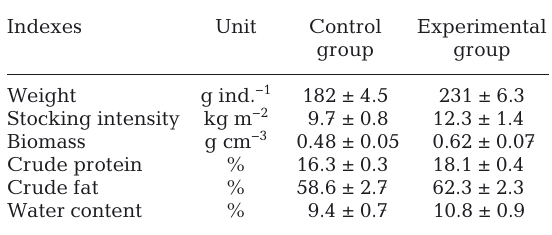
5. Mean (±SD) yield and quality of Eriocheir sinensis crabs with practical application of biochar-immobilized am- monia nitrogen and phosphate removal strains (ANRS and PRS; 4 g l −1 ). Control group was given no biochar-immobilized ANRS and PRS; experimental group was challenged by biochar-immobilized ANRS and PRS. Crabs sampled per treatment = 50; all measured crab parameters were signifi- cantly different between treatments at p <